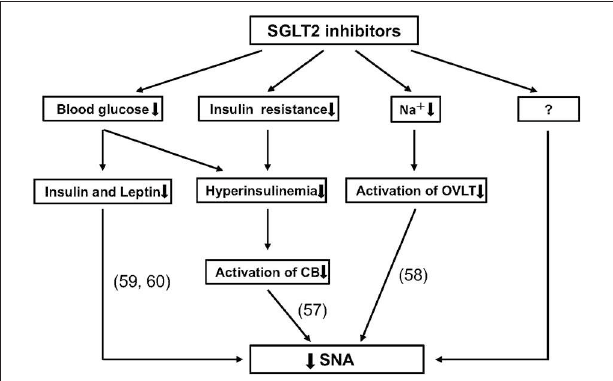
FIGURE 3 | Possible mechanisms for reducing sympathetic nervous activity (SNA) through use of sodium-glucose cotransporter 2 (SGLT2) inhibitors. Recent studies have suggested that SGLT2 inhibitors elicit a reduction in SNA by decreasing insulin, leptin (59, 60) and blood glucose levels; and by improving insulin resistance and hyperinsulinemia, which could reduce the activation of carotid body (CB) (57); as well as by reducing sodium volume, which inhibits the activation of organum vasculosum laminae terminalis (OVLT) ( 58). Importantly, there are likely to be other mechanisms that have not been